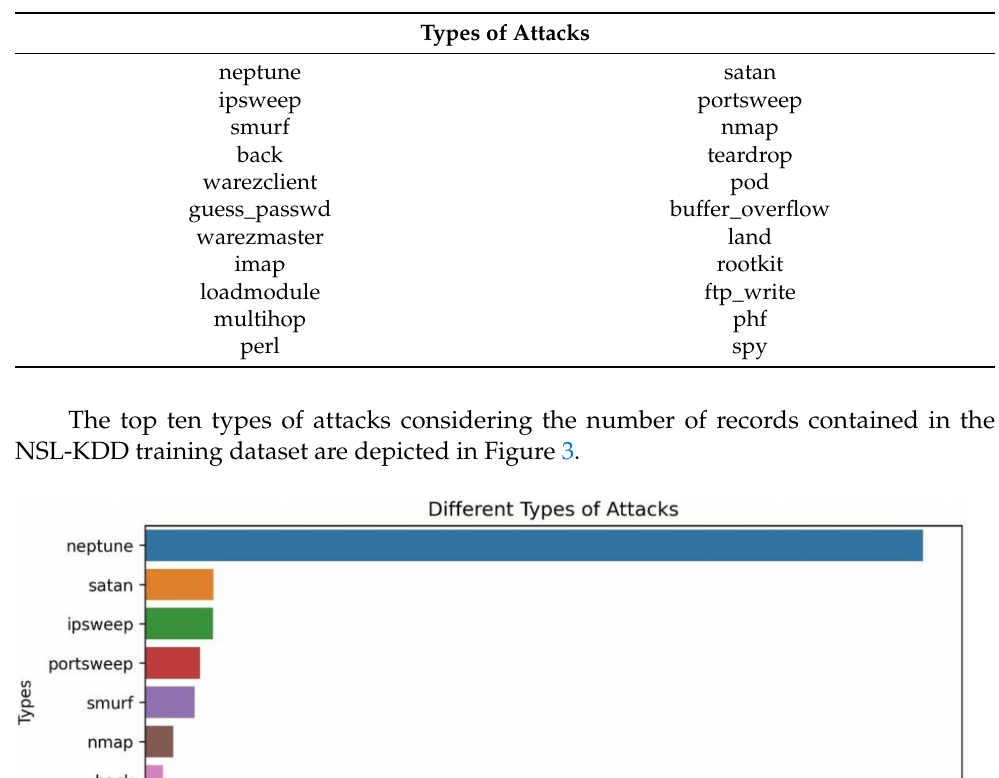
Table 1. Types of attacks in the NSL-KDD dataset [35].